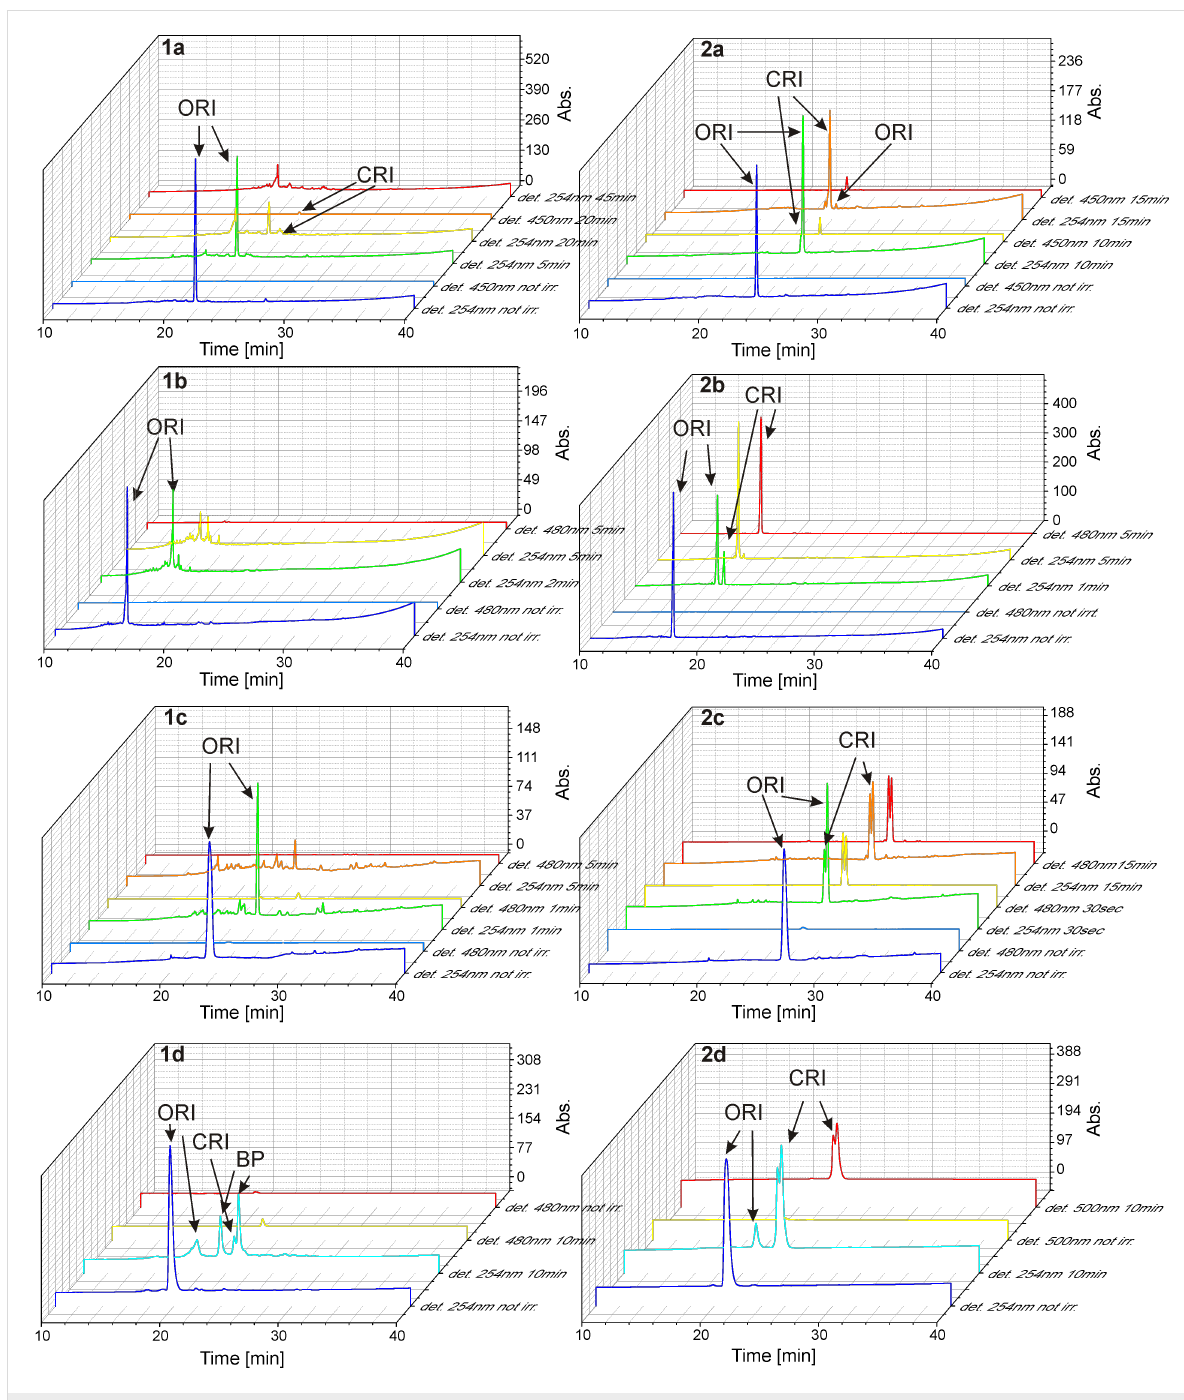
Figure 4: Stability analysis of compounds 1b–d and 2b–d upon different times of UV irradiation, monitored by HPLC with detection at 254 nm and at the absorption maximum of the closed-ring form. ORI: open-ring isomer, CRI: closed-ring isomer, BP: